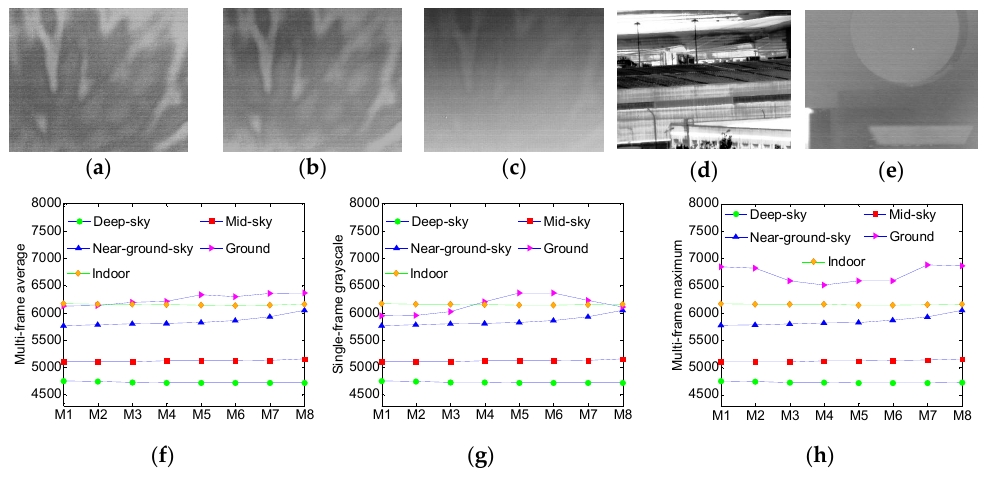
Figure 11. Statistical properties of several scenes. ( a ) Deep-sky image; ( b ) mid-sky image; ( c ) near-ground-sky image; ( d ) ground scene image; ( e ) indoor scene image; ( f ) multi-frame average of blocks; ( g ) single-frame grayscale of blocks; and ( h ) multi-frame maximum grayscale of blocks. In order to verify the accuracy of the fuzzy classifier, we assume that the images with v out between 0.7 and 1 are sky images, between 0.4 and 0.7 are half-sky images, and between 0 and 0.4 are ground images. Another image sequence of 9044 frames was collected in June 2016 using the same imager. These frames were artificially identified as: five sets of all-sky scenes totaling 2995 images, five sets of half-sky scenes totaling 1200 images, and four sets of ground scenes totaling 4849 frames. Each set of images was stored in a DAT file, so each file was the same kind of scene. Then our MATLAB